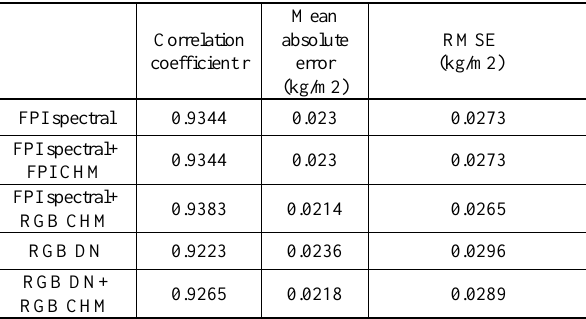
Table 3. Biomass estimation results: Correlation coefficient, Mean absolute error and root-mean-square error (RMSE) from professional drone data using multiple linear regression models with different variable